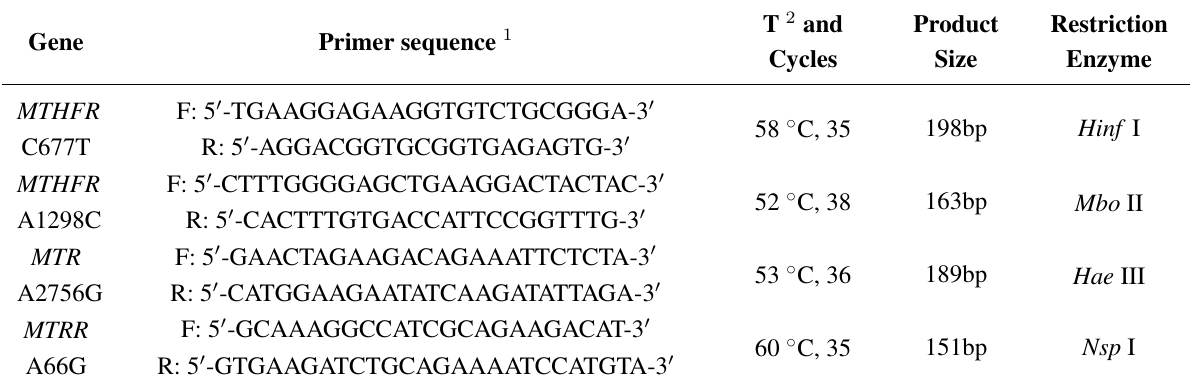
T 2 and Product Restriction Cycles Size Enzyme